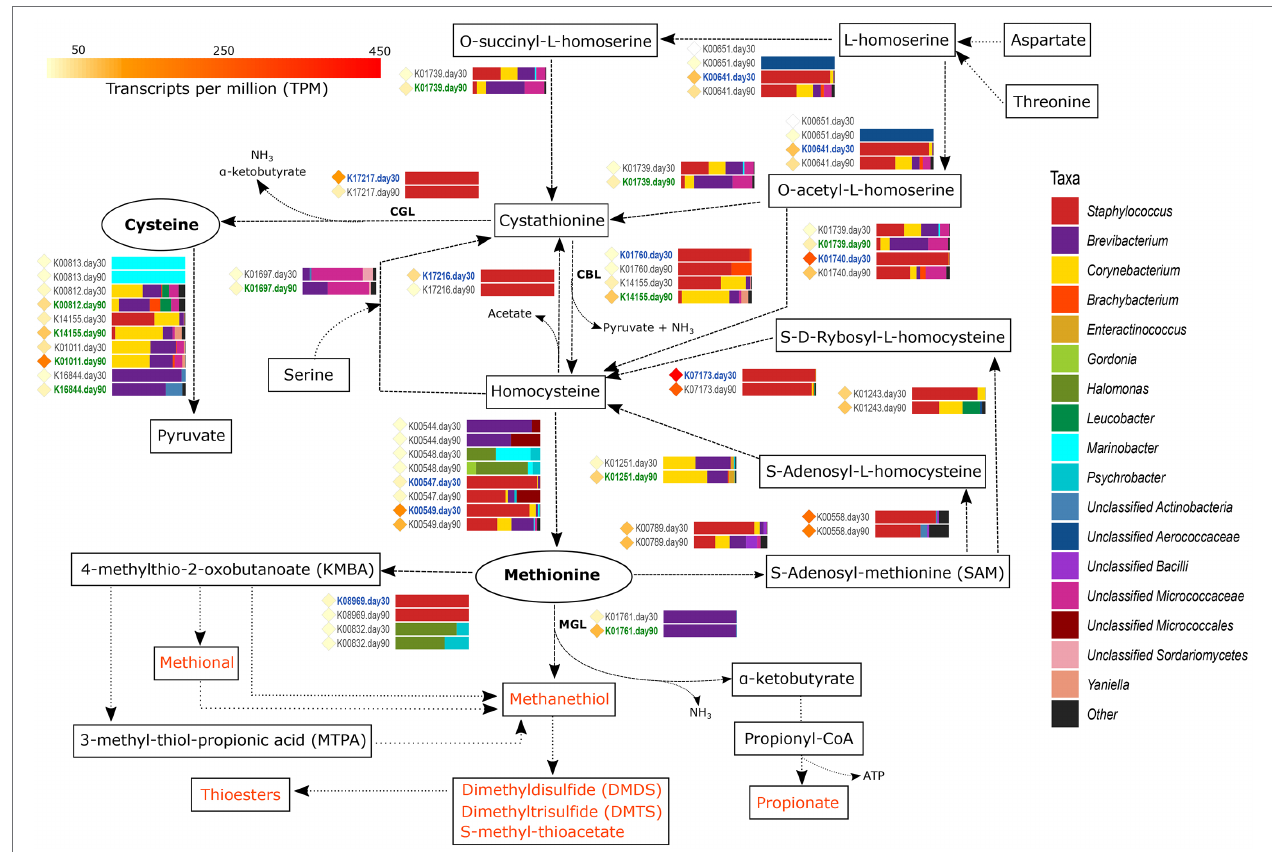
FIGURE 3 | Metabolism of sulfur-containing amino acids. The different compounds that are generated in each metabolic pathway are showed and those harboring important organoleptic properties for cheese are colored in orange. The different metabolic pathways can be followed according to the corresponding arrows. Between every pair of compounds, the genes involved in such reactions are shown with their KEGG orthologue (KO) name. TPM values of each gene are shown as colored diamonds next to their corresponding KO name, which is colored in blue or green if significant transcription was identified for such KO day 30 or 90, respectively ( p < 0.05). Next to the KO names, the horizontal bar-plots represent the percentage of transcripts for that KO and ripening time that was associated with the different